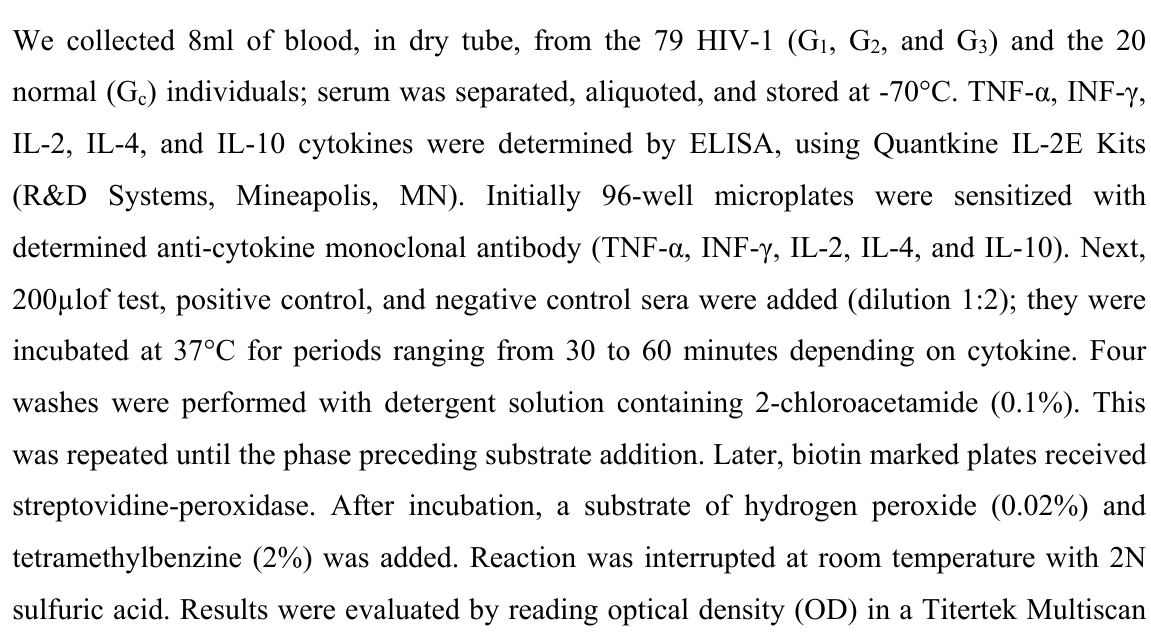
D. A. Meira et al. CORRELATION BETWEEN CYTOKINE SERUM LEVELS, NUMBER OF CD4 + T CELLS/mm³ AND VIRAL LOAD IN HIV-1 INFECTED INDIVIDUALS WITH OR WITHOUT ANTIRETROVIRAL THERAPY.